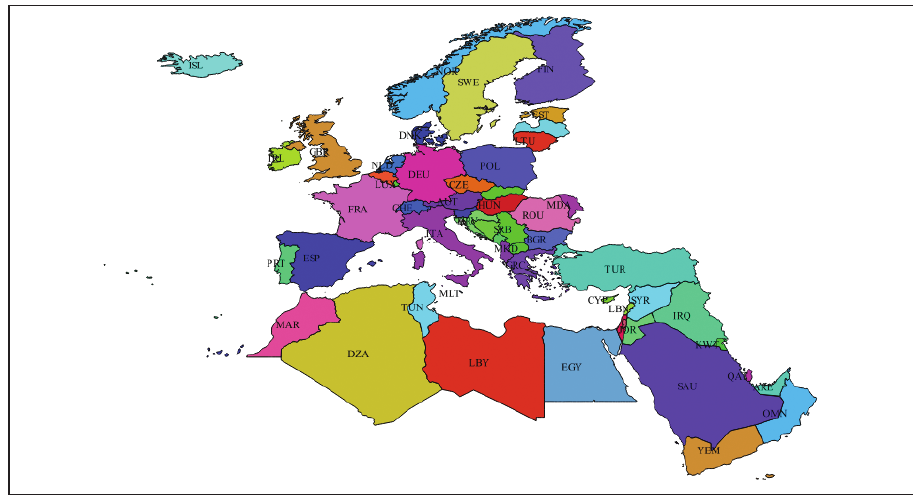
Figure 1. Countries including in the risk ranking model, labelled with their international codes